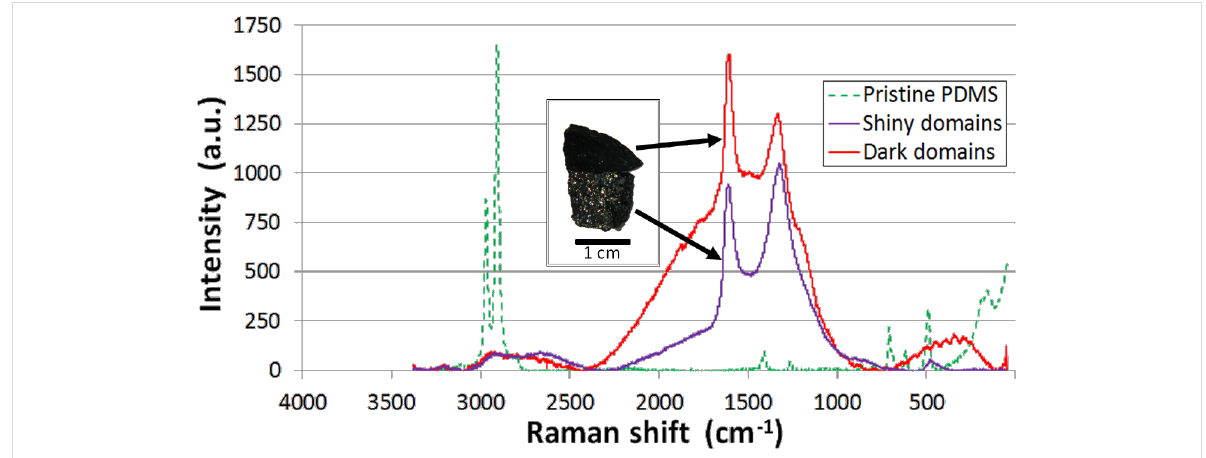
Figure 2: Comparison of Raman spectra: pristine PDMS, carbon nanotubes (shiny domains) and graphite nanocrystals (dark domains).